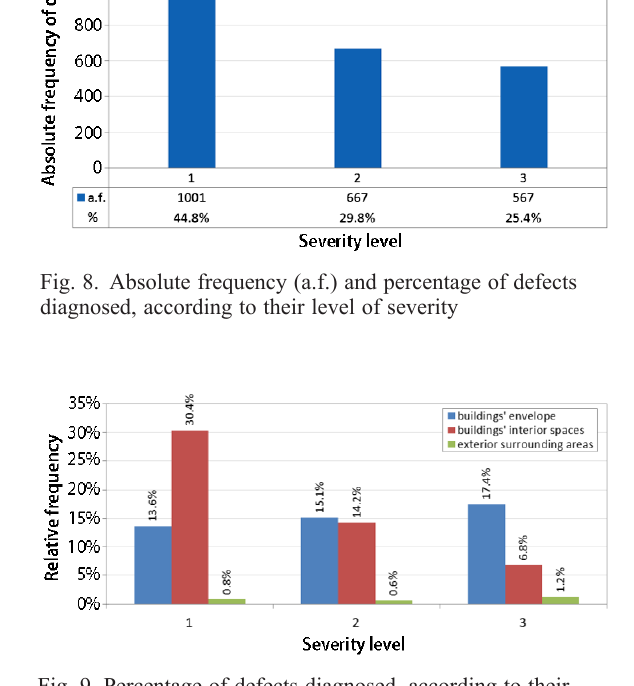
Fig. 9. Percentage of defects diagnosed, according to their level of severity, in the buildings’ envelope, in interior areas and in external surrounding